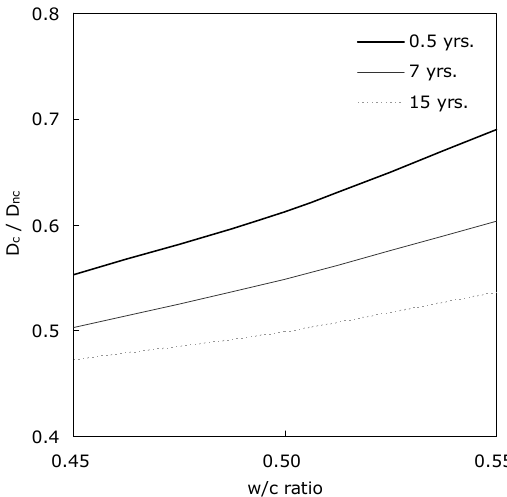
Figure 9. E ff ective CO 2 di ff usivity (D c ) of carbonated concrete vs. e ff ective CO 2 di ff usivity (D nc ) Figure 9. Effective CO 2 diffusivity (D c ) of carbonated concrete vs. effective CO 2 diffusivity (D nc ) before before carbonation.